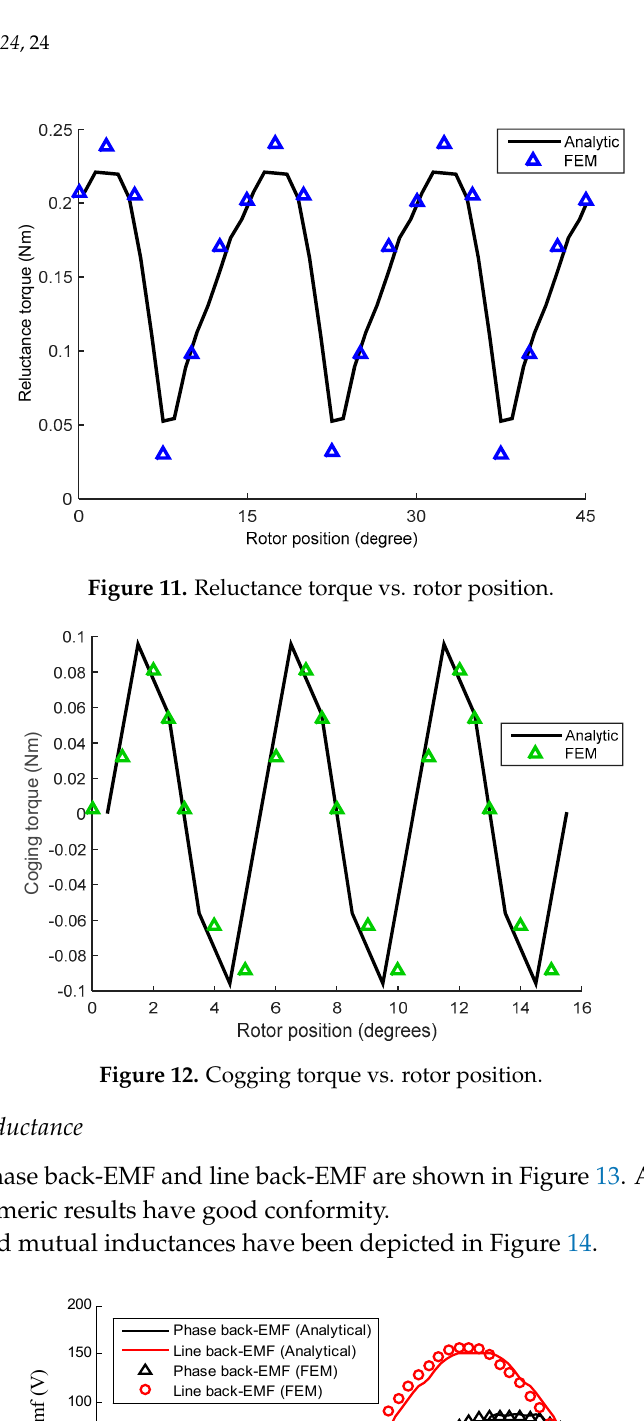
Figure 10. Electromagnetic torque vs. rotor position.